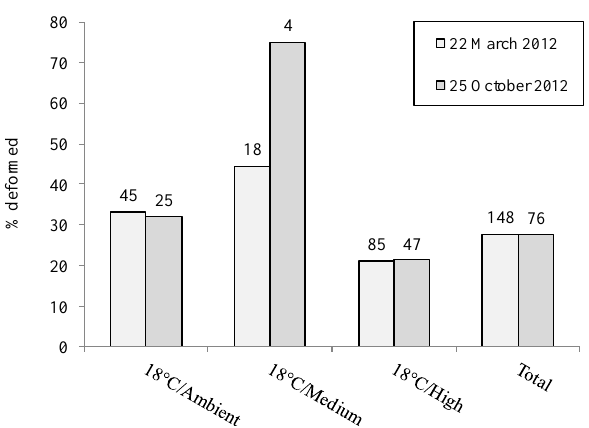
Figure 8. Fig. 8. The percentage of juveniles with deformities. Light grey bar represents juveniles surviving five months of p CO 2 exposure (am- bient, medium and high) and darker grey bar the juveniles after an- other seven months in ambient water only. Total number of juveniles in each category is given above each